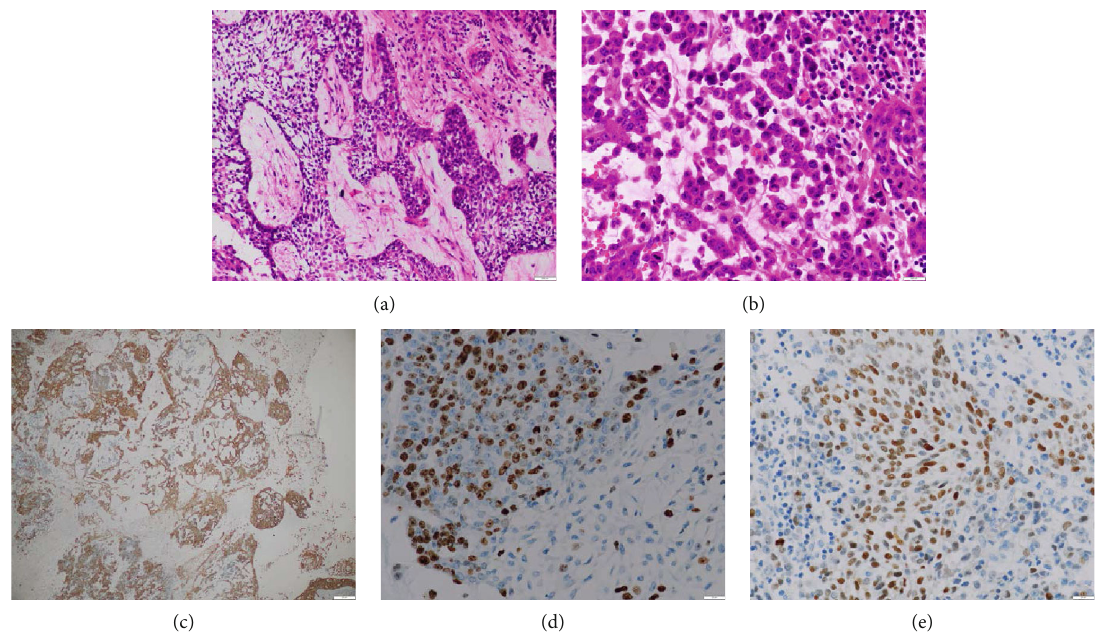
Figure 3: Photomicrographs showing sheets and nests of ameloblastic epithelium with in fl ammatory in fi ltration ((a) hematoxylin eosin); areas of tumor cells with hyperchromatism, nuclei pleomorphism, and some mitotic fi gures ((b) hematoxylin eosin); marked positive immunohistochemical expression of CK19 (c), Ki67 (d), and p53 (e).